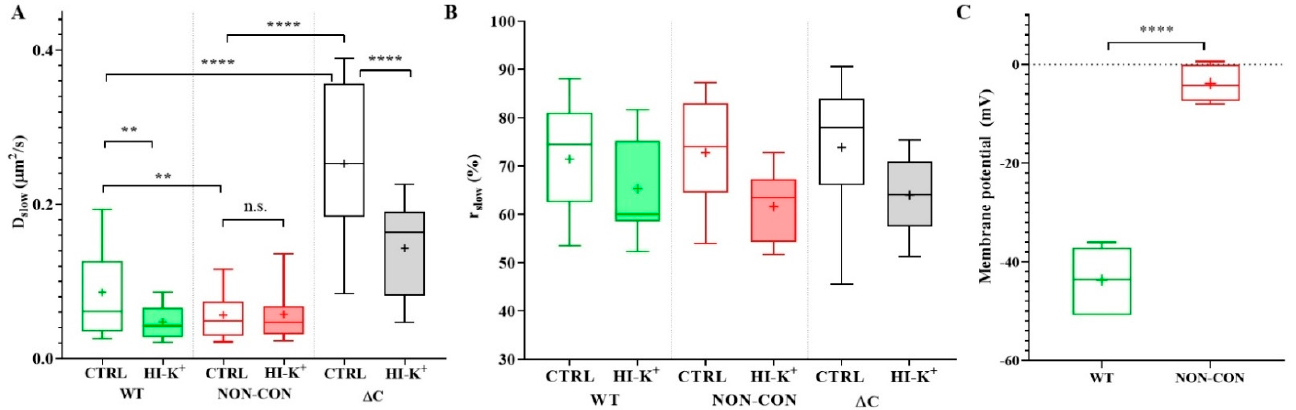
Figure 1. Diffusion properties of WT and mutant Kv1.3 channels in standalone cells. ( A ) Diffusion coefficient of the slow component. The mobility of the wild type mGFP-tagged Kv1.3 channel (WT) was compared to that of non-conducting point mutant (NON-CON) and C-terminal deleted mutant ( Δ C) Kv1.3 channels (empty boxes) expressed in Jurkat cells. The NON-CON mutant channel has the lowest mobility, and the Δ C mutant has the highest mobility. Depolarization by high external K + concentration using high K + solution decreased the mobility of the WT and Δ C channels significantly (filled boxes). ( B ) Average proportions ( r slow ) of the slow component of the different Kv1.3 channels did not differ significantly. ( C ) Membrane potential of Jurkat cells expressing WT mGFP-Kv1.3 and the NON-CON mutant measured by patch clamp. On the box-and-whiskers plots, boxes represent the values of the 25th to 75th percentiles, whereas whiskers represent the 10th and 90th percentiles, the midline is the median value, and “+” marks the arithmetic mean. Mean values were compared with ANOVA and Student’s t -test. ** p < 0.01, **** p < 0.0001, n.s. not significant. Table 1. Slow diffusion coefficient values of the examined molecules. Data are given in units of µm 2 /s as mean ± standard deviation. Values in the brackets denote the number of measured points. We used Jurkat T cells (standalone or forming an IS with Raji B cells) unless mentioned otherwise. * Diffusion constant of mCherry-Kv1.3 was also determined in murine D10 cells forming an IS with CH12-LX B cells, using a model with a single diffusing component.